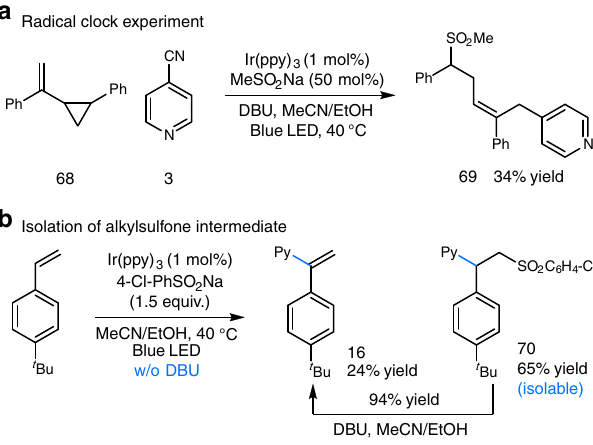
Fig. 6 Mechanistic studies. a Radical clock experiment. b Isolation of alkyl sulfone